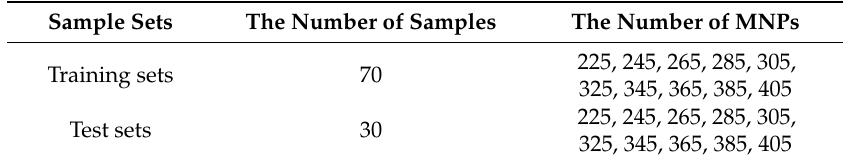
Table 7. The samples sets (training sets and test sets) corresponding to the optimal group of positions